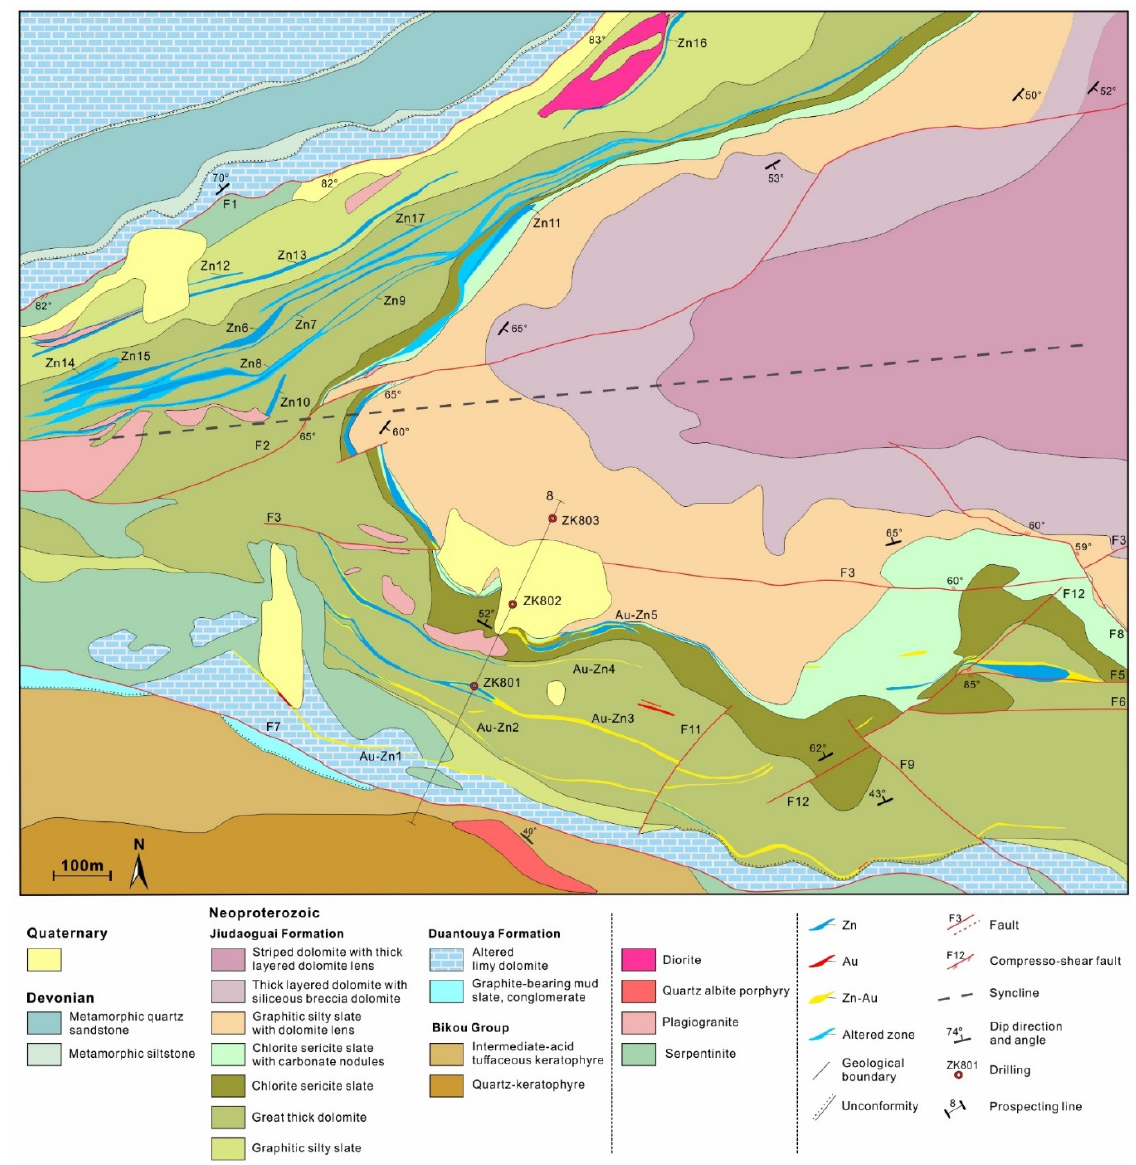
Figure 2. Geological map of the Liushuping Au–Zn deposit. The magmatic rocks include the quartz albite porphyry exposed in the south of the ore district, diorite in the north, and plagiogranite in the northwest, as well as serpentin ‐ ized ultrabasic rocks (Figure 2). The fault structure in the ore district can be divided into three groups, nearly EW ‐ , NE ‐ , and NW ‐ trending, respectively. The nearly EW ‐ trending